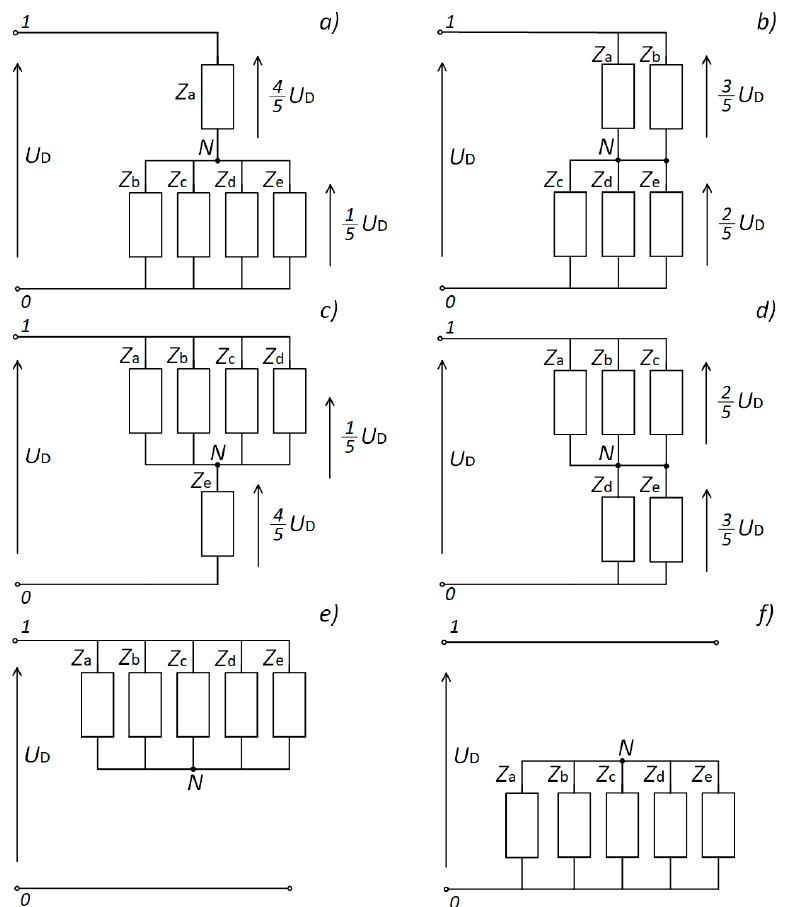
Figure 7. A few possible arrangements of the star connected load, where: ( a ) corresponds to the vector V 16(10000) , ( b ) corresponds to the vector V 24(11000) , ( c ) corresponds to the vector V 30(11110) , ( d ) corresponds to the vector V 28(11100) , ( e ) corresponds to the vector V 31(11111) , ( f ) corresponds to the vector V 0(00000) .